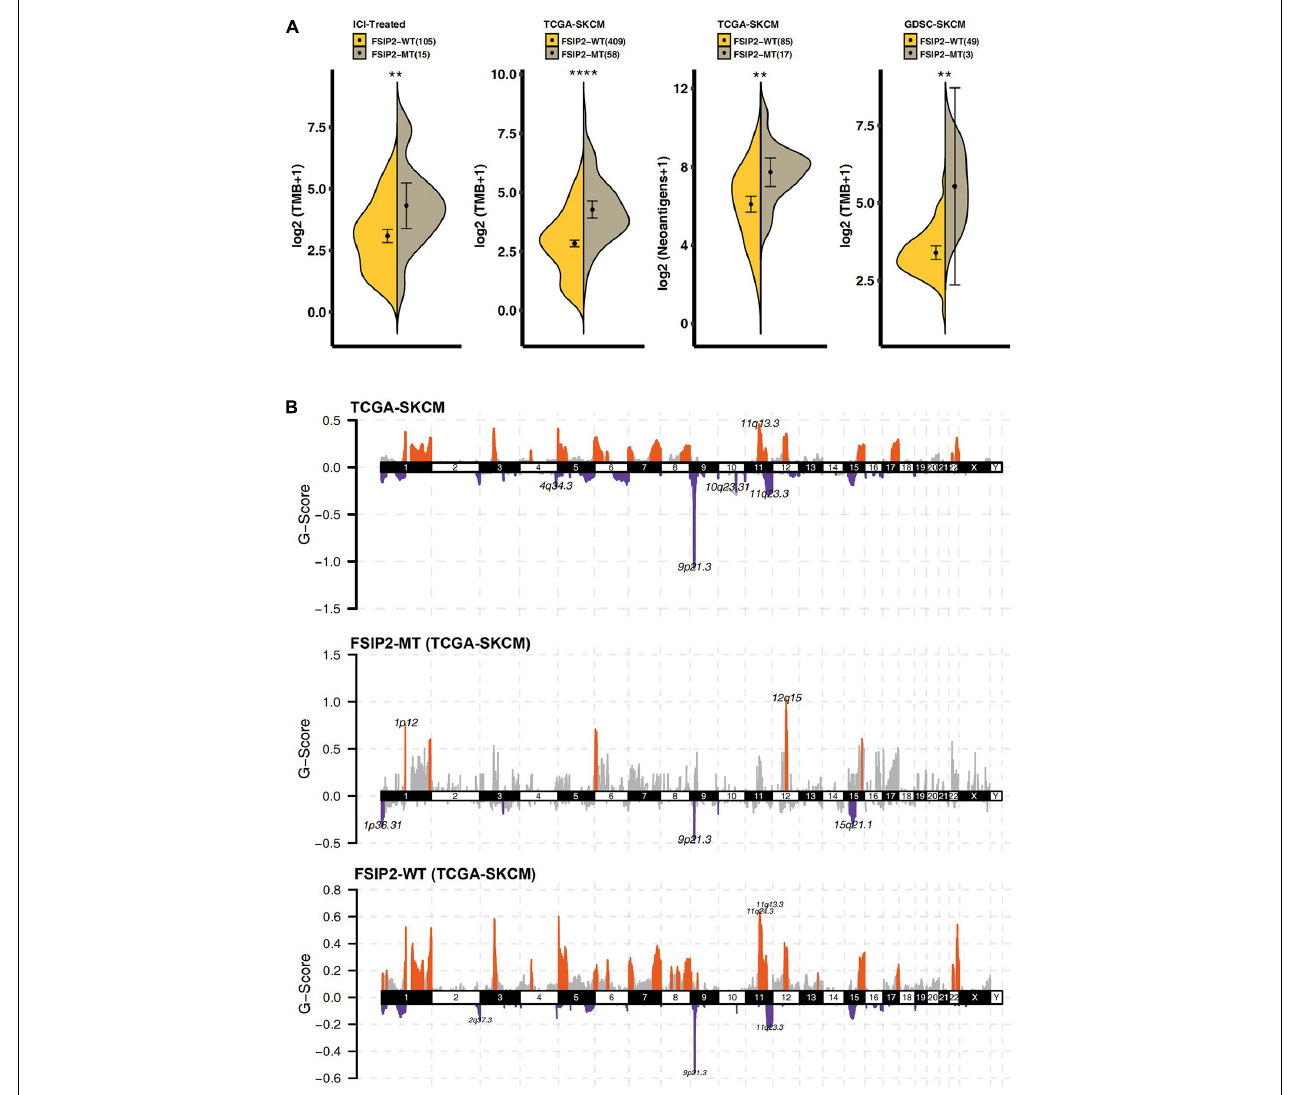
FIGURE 3 | Tumor immunogenicity and CNV analyses of TCGA-SKCM. (A) We used the Mann-Whitney U test to compare the TMB levels (along the y -axis) of the FSIP2-MT group (gray) and the FSIP2-WT group (yellow) in the ICI-treated cohort, TCGA-SKCM cohort and GDSC-SKCM cohort and the tumor neoantigen load (along the y-axis distribution) in the TCGA-SKCM cohort. The numbers in parentheses indicate the total number of patients included in the analysis of each dataset, with *indicating significant differences. The results showed that the FSIP2-MT group had significantly higher TMB levels than the FSIP2-WT group, and the NAL in the FSIP2-MT group was significantly higher. (B) The CNV of the TCGA-SKCM cohort was analyzed using GISTIC2.0. We set the x -axis as the chromosome number and the y -axis as the G-score. The amplified part is displayed above the x -axis, and the markedly amplified part is marked with red; the deleted part is displayed below the x -axis, and the markedly deleted part is marked with blue (** p < 0.01; **** p < 0.0001).